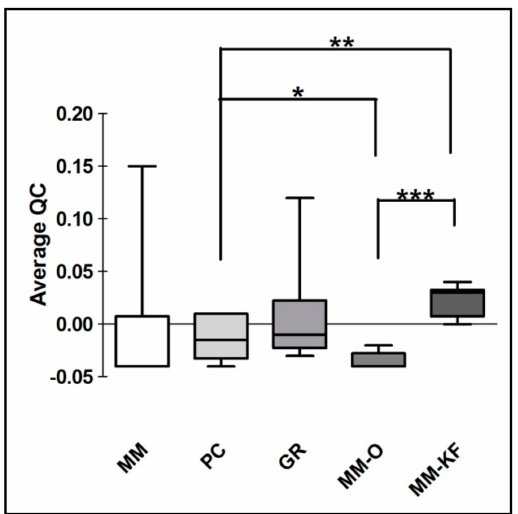
Figure 4. QuantiMIZE QC values comparison for DNA extracted using both manual procedures (MM, PC and GR) and automatic workstations (MM-O and MM-KF). * p < 0.05, ** p < 0.001, *** p < 0.0001 t -test.